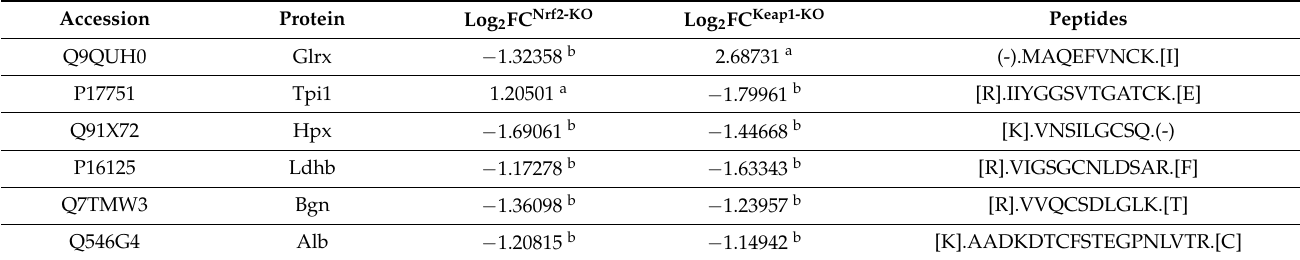
and redox proteomic analysis (Table 5). Interestingly, there was no significant change in the global expression profile of proteins with the corresponding redox peptides that were significantly altered in Nrf2 and Keap1 deletion knockouts, indicating the independent regulation of global expression changes and redox homeostasis. Table 4. Common Nrf2/Keap1 knockout redox sensitive significantly differentially expressed peptides.